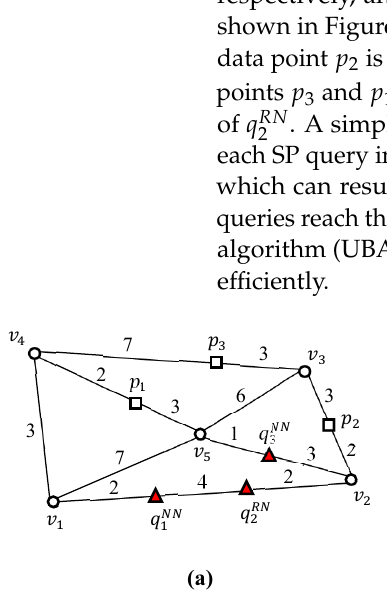
Figure 2 is a system diagram of the proposed UBA between query points and